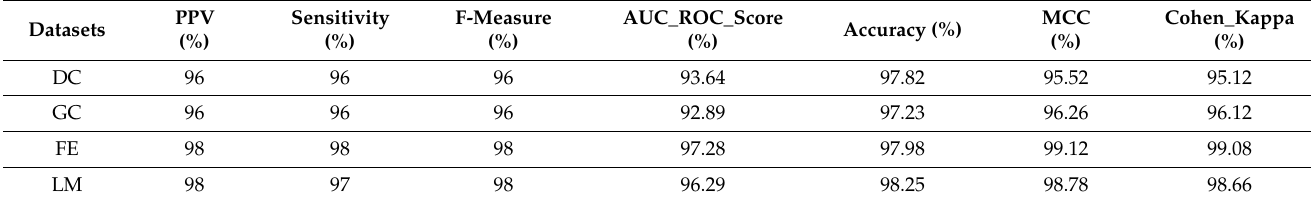
Table 10. Results of ANN algorithm.